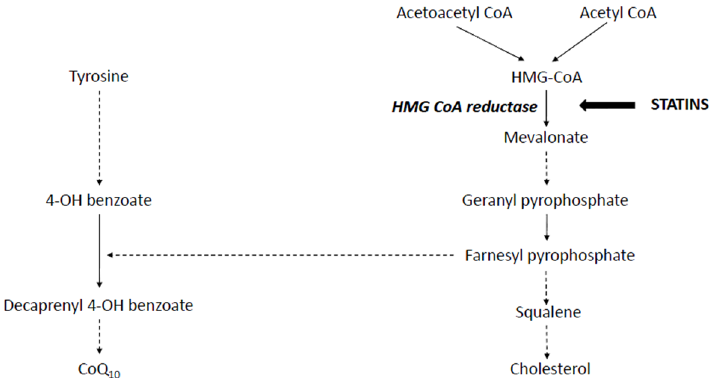
Figure 1. Schematic representation of cholesterol and CoQ10 synthetic pathway. Dotted arrows are used where some of the intermediate products in the pathway have been omitted in the diagram. Site of Statin action is shown. Statin inhibits enzymes HMG CoA reductase which is written in bold italics.